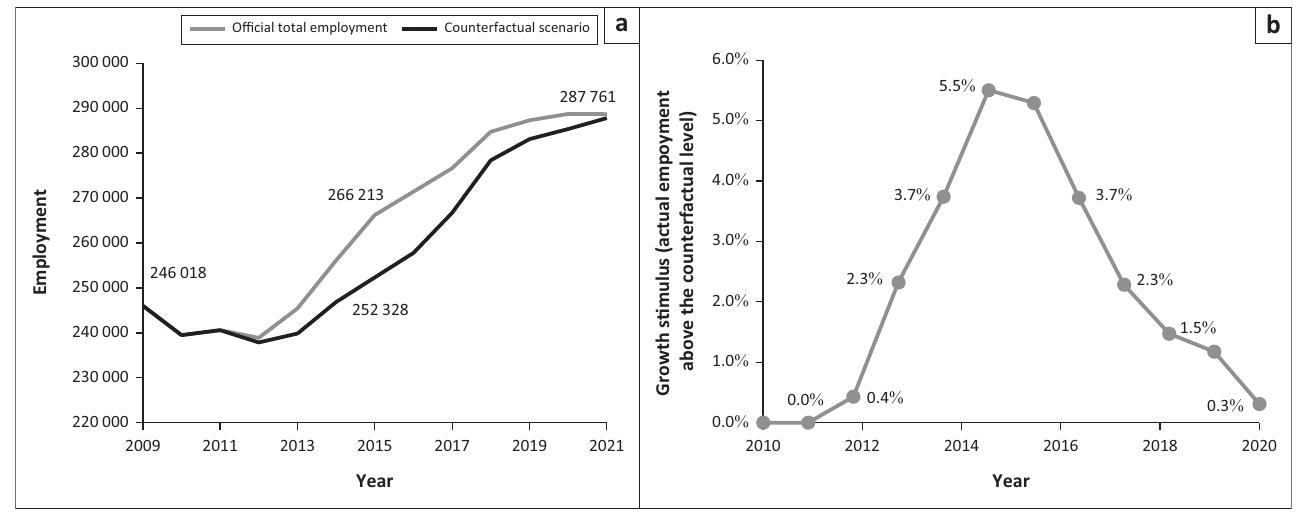
FIGURE 3: (a) Summary of results for Canterbury employment, 2009–2021. (b) Growth stimulus in employment from investment injection,